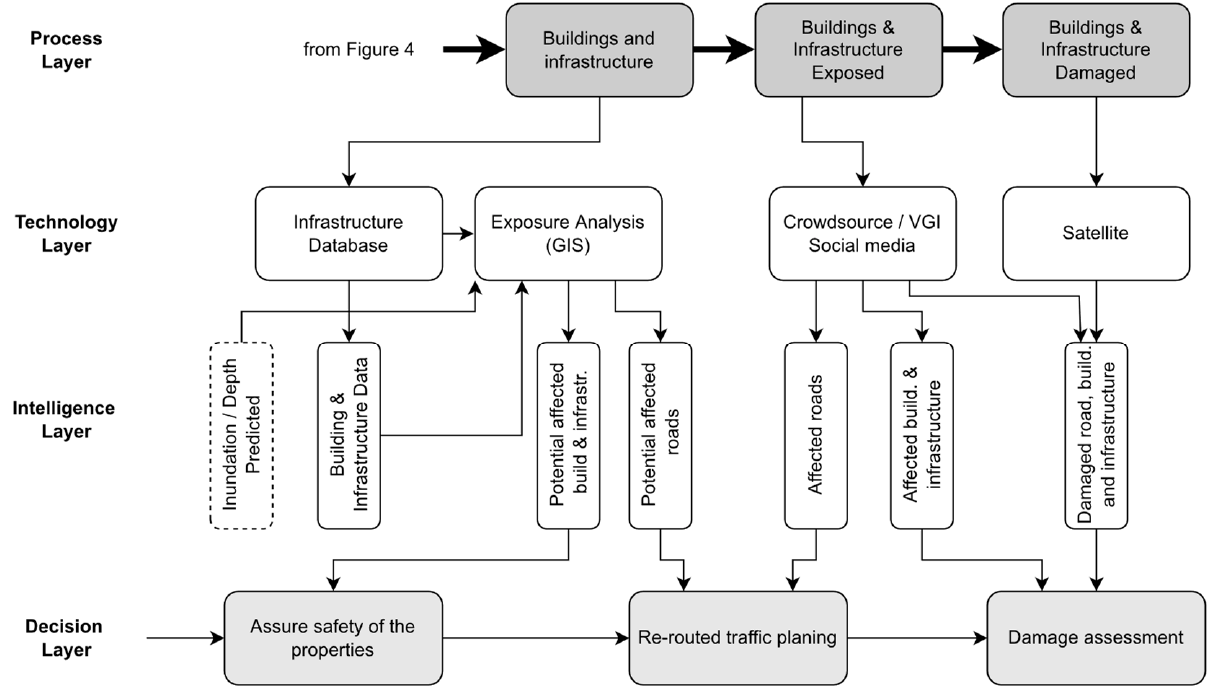
Figure 6. Intelligence required for identifying affected infrastructure.